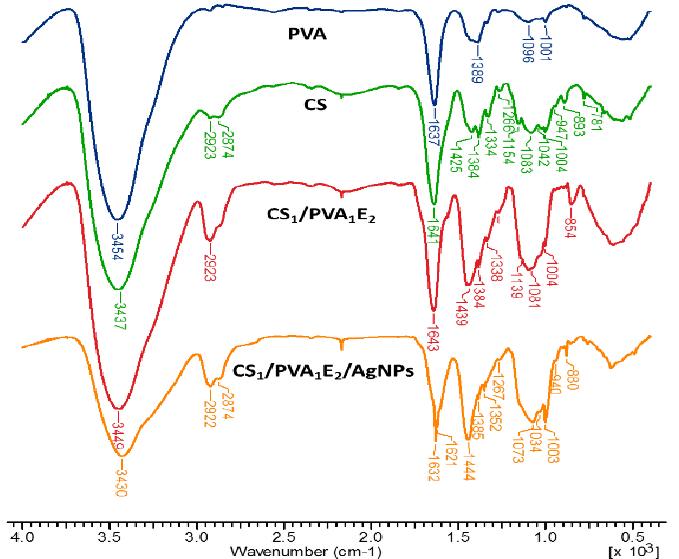
Figure 2. FT–IR spectra of chitosan (CS), poly(vinyl alcohol) (PVA), cross-linked hydrogels (CS 1 /PVA 1 E 2 ), and hydrogel loaded with silver nanoparticles (CS 1 /PVA 1 E 2 /AgNPs).